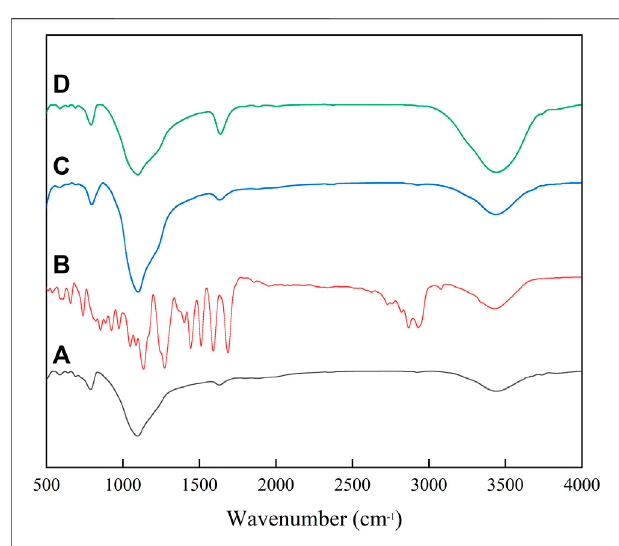
FIGURE 3 | FT-IR spectra of (A) SiO 2 /zeolite, (B) 4-FB15C5, (C) CE@ SiO 2 /zeolite, and (D) adsorption of CE@SiO 2 /zeolite for Li( Ι